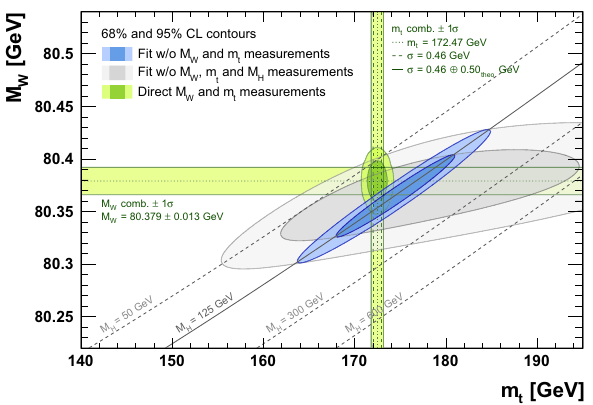
Fig. 5 Contours at 68 and 95% CL obtained from scans of M W versus m t for the fit including (blue) and excluding the M H measurement (grey), as compared to the direct measurements (green vertical and horizontal 1 σ bands, and two-dimensional 1 σ and 2 σ ellipses).